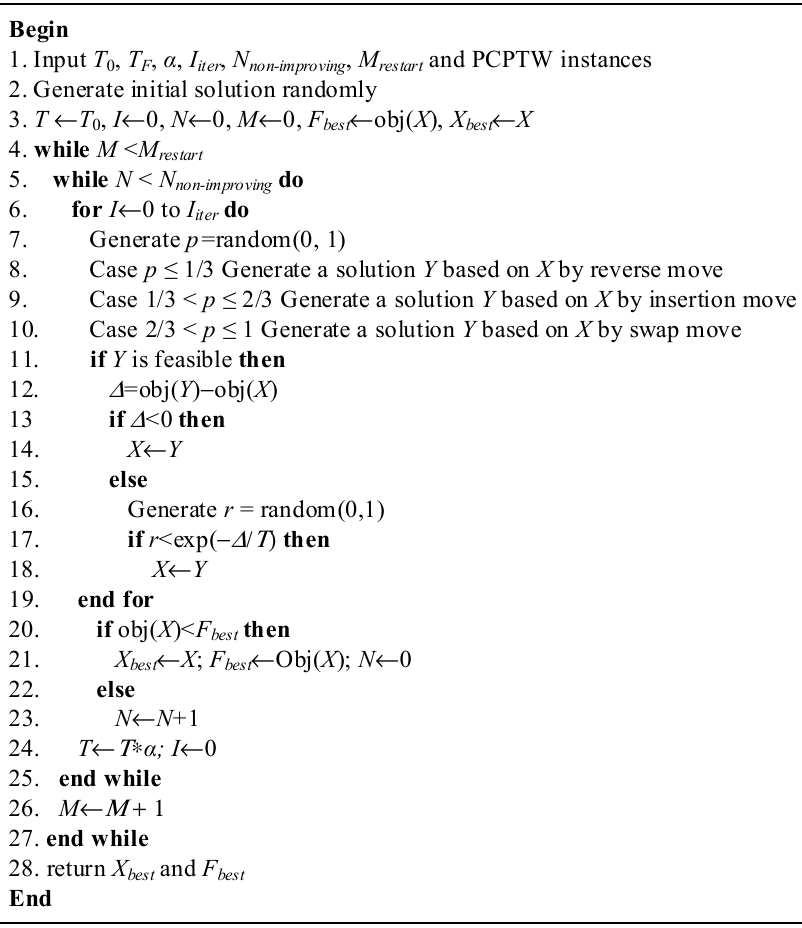
Figure 4. Pseudocode of the proposed SARS